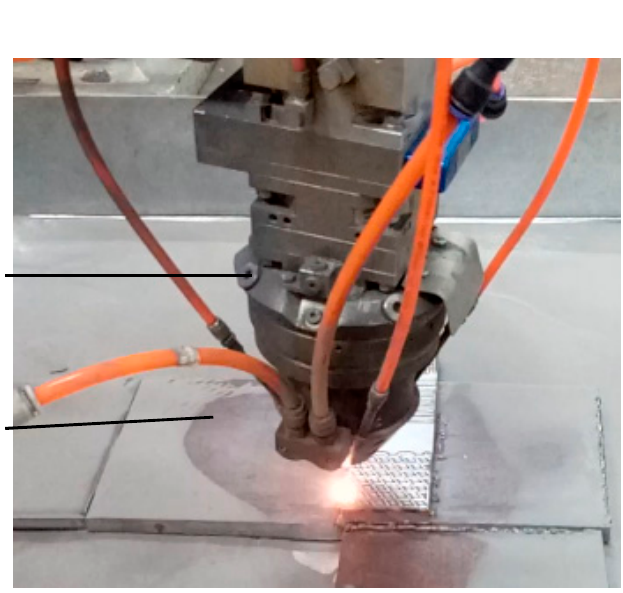
Figure 1. Single pass laser cladding experiment.